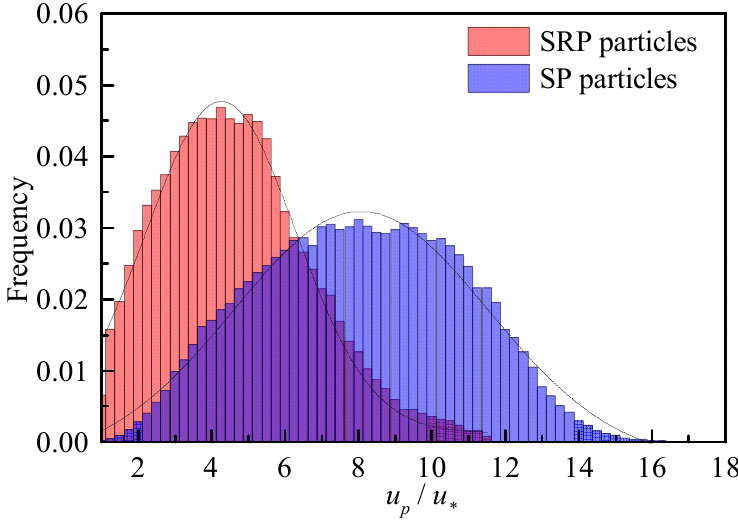
from the flow than the SRP. Furthermore, bed resistance has greater influence on the SRP than the SP.